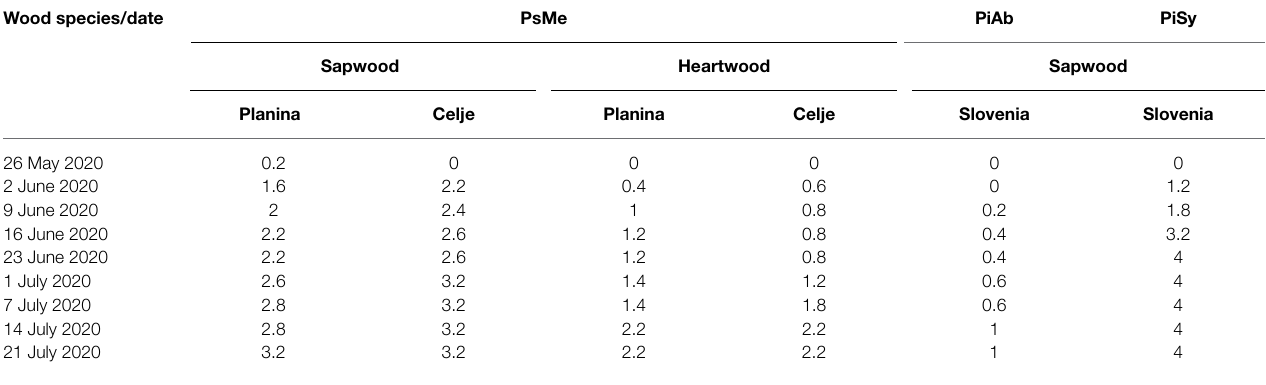
TABLE 5 | Sapstain development in the condensing chamber in the 2 months between 19 May 2020 and 21 July 2020. Wood species/date PsMe PiAb PiSy Sapwood Heartwood